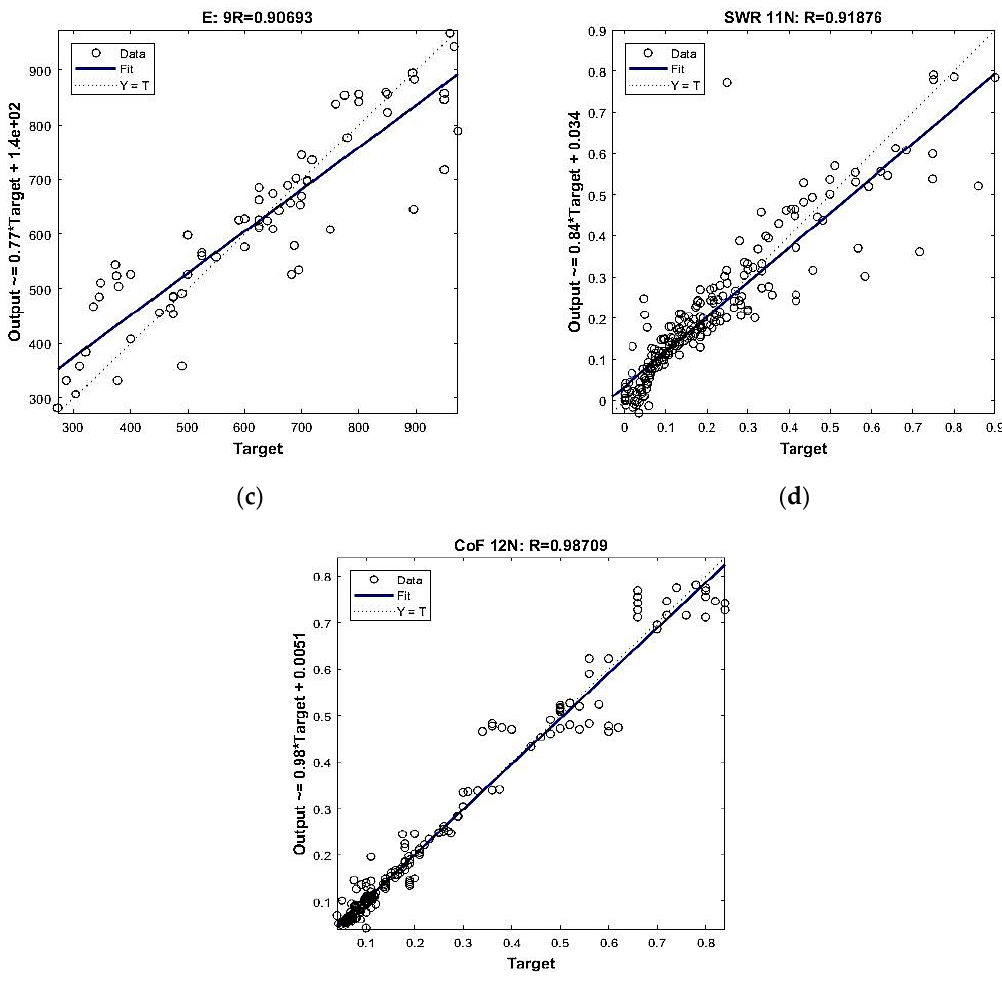
Figure 3. Predictability of the ANN models for ( a ) UTS, ( b ) H, ( c ) E, ( d ) SWR, and ( e ) CoF.